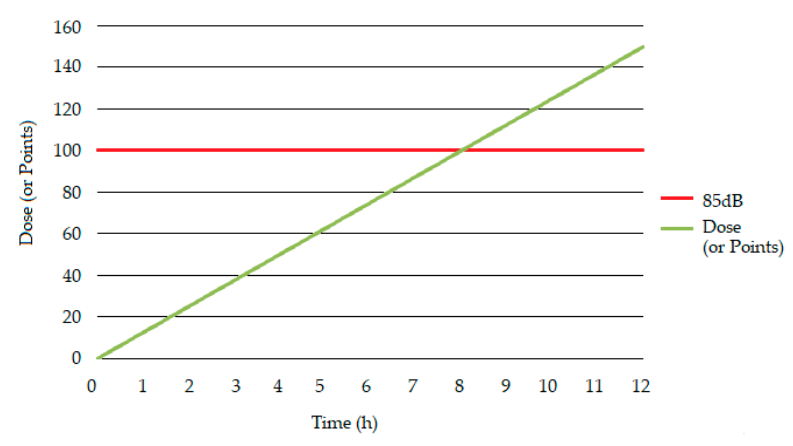
Figure 7. Relationship between %Dose (or points) and Time (Leq of 85 dBA).